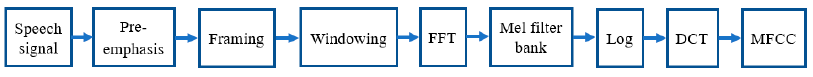
Figure 3. Complete MFCC feature extraction process.